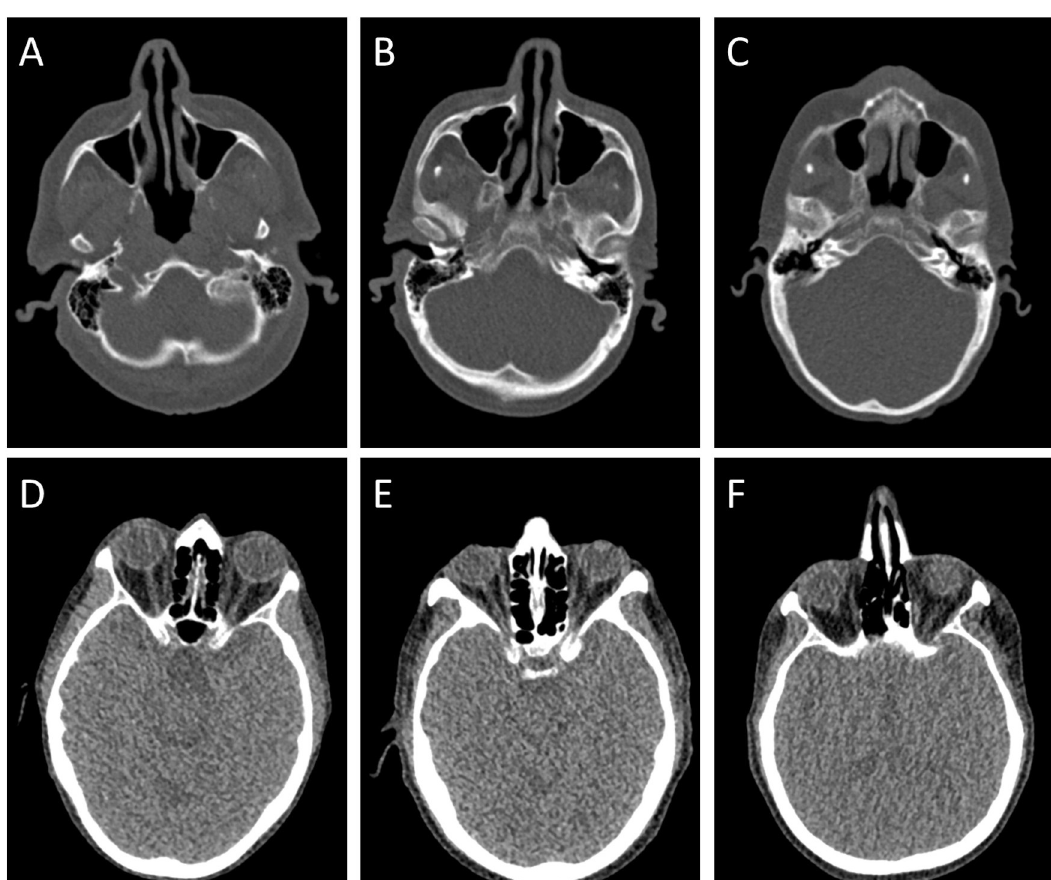
Fig 2. Examples of different image quality scores. Axial bony reformations show good (A), moderate (B) and fair (C) distinction of the individual mastoid cells. Axial soft-tissue reconstructions show moderate (D), fair (E) and non-diagnostic (F) image quality regarding the differentiation of orbital